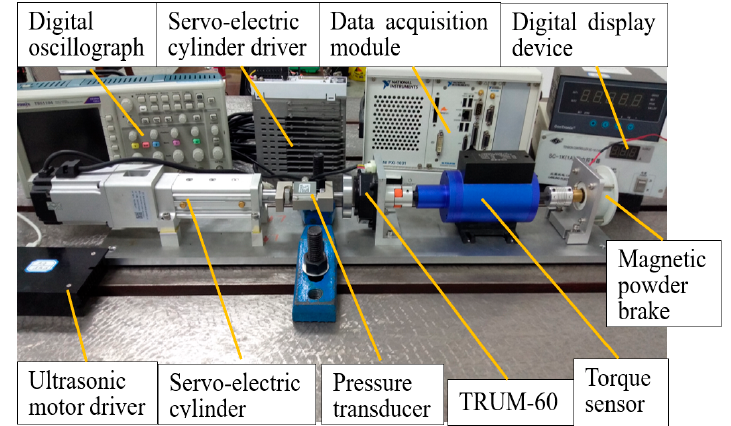
Figure 4. Diagram of ultrasonic motor experimental